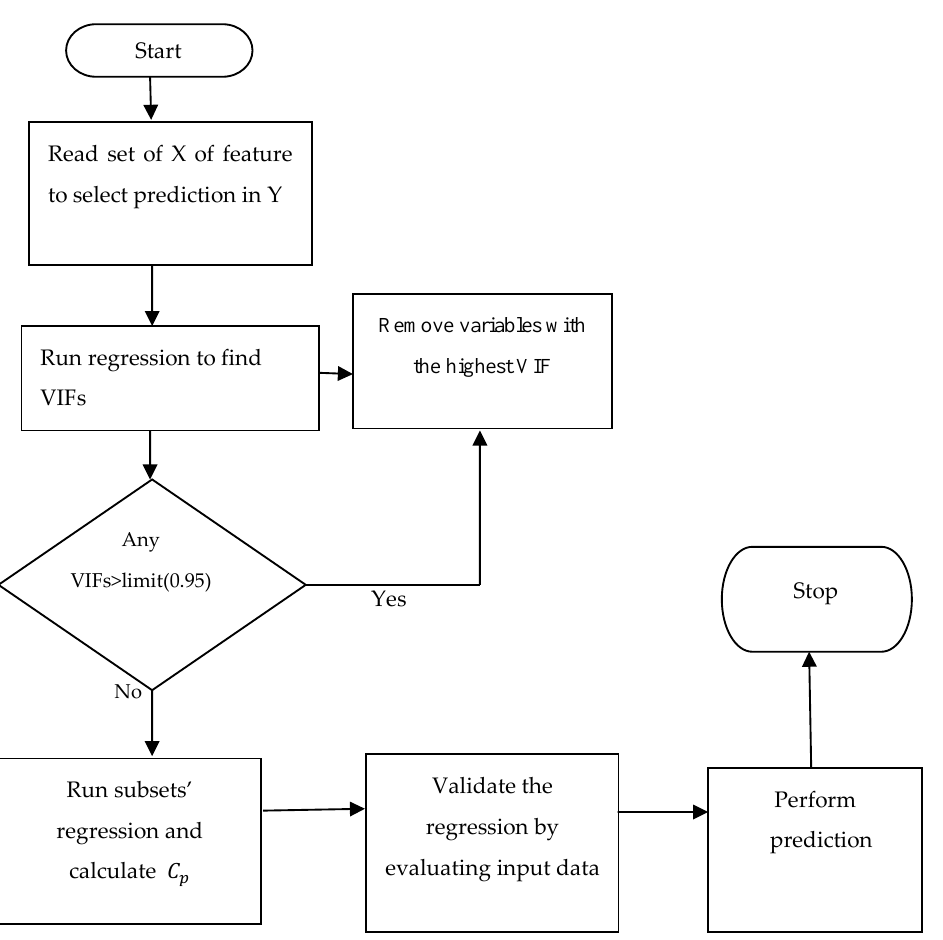
Figure 8. MLR algorithm flowchart.